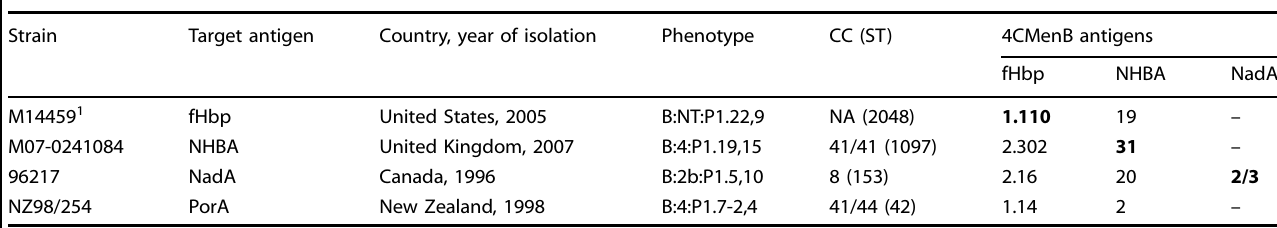
Table 2. Characteristics of the 4 indicator